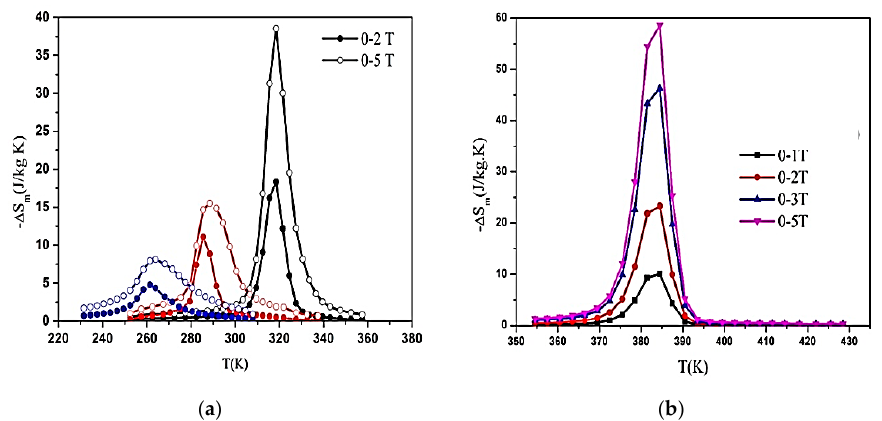
Figure 8. Magnetic entropy variation ∆ S m for ( a ) Mn 1.4 Fe 0.6 P 0.3 Si 0.7 (blue) Mn 1.3 Fe 0.7 P 0.35 Si 0.65 (red) and Mn 0.7 Fe 1.3 P 0.65 Si 0.35 (black) under 0–2 T (black dots) and 0–5 T (open circles) magnetic field shifts, respectively; ( b ) MnFeP 0.5 Si 0.5 for several magnetic field shifts.